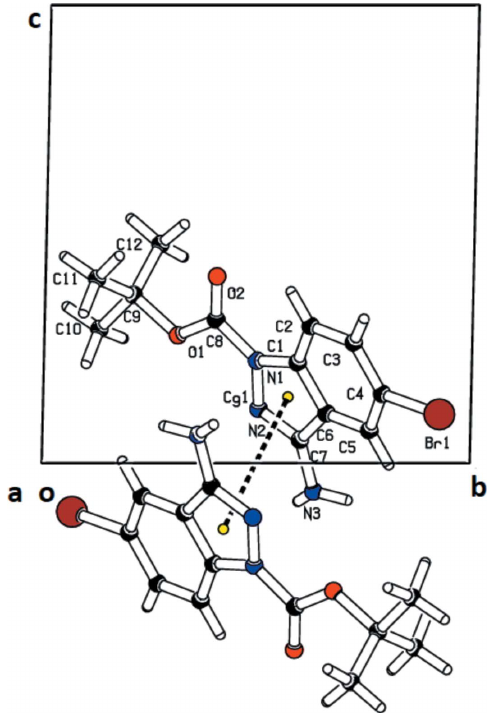
Figure 3 A view of the (cid:2) – (cid:2) interaction along the a -axis direction.